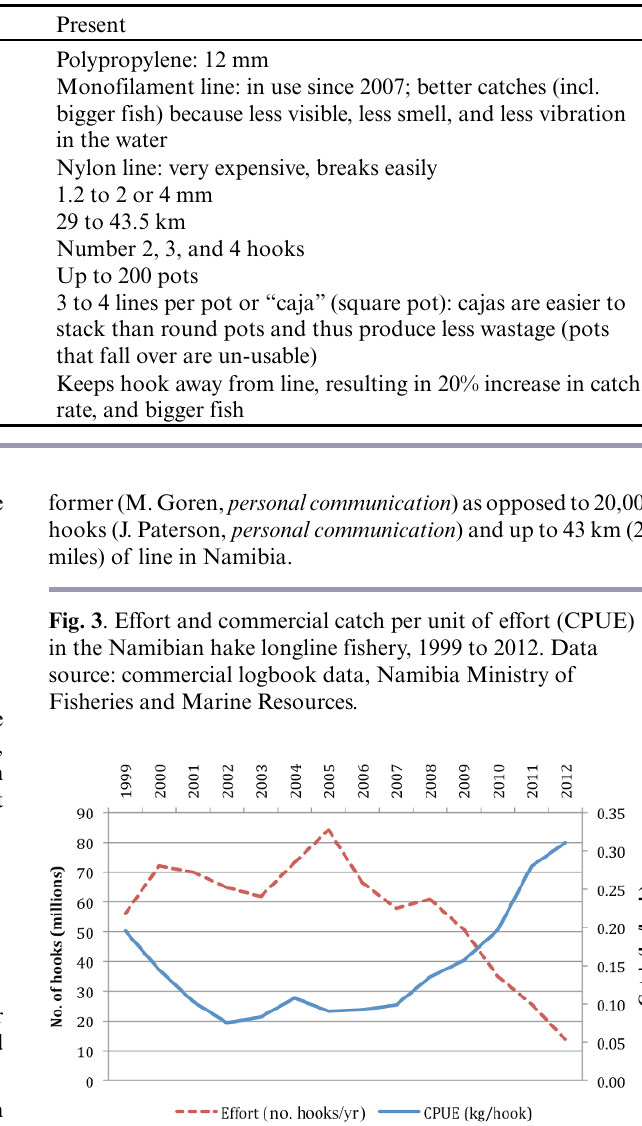
Table 2 . Changes in fishing gear, from past to present.